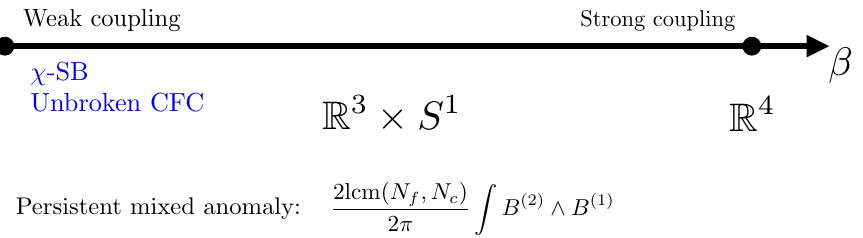
Figure 2 . By employing graded partition function (1.11), we prove chiral symmetry breaking at weak coupling for various SU( N ) gauge theories with N massless fundamental Dirac fermions and c f one massive adjoint fermion. This is done by using semi-classical methods and index theorem for Dirac operator on R 3 × S 1 in non-trivial gauge Ω and flavor Ω 0 holonomy background. There exists F a mixed anomaly polynomial that persists at any compactification scale β (both at weak and strong coupling) if and only if one uses Ω 0 background. The combination of the two methods does not F suffice to analytically prove χ -SB at strong coupling and R 4